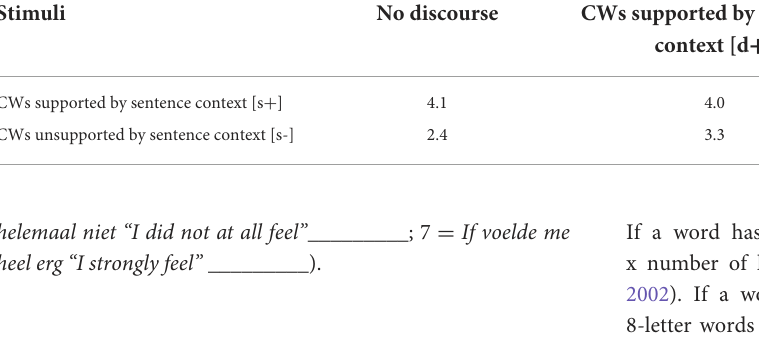
TABLE 2 Pretest results: Plausibility ratings of critical words (CWs) supported and unsupported by the critical sentence with and without discourse context.